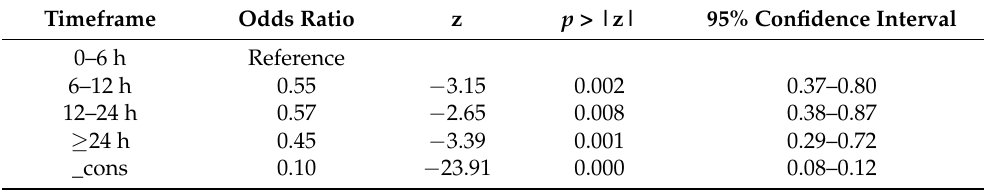
Table 4. The univariate mortality risk according to the symptoms-to-endoscopy